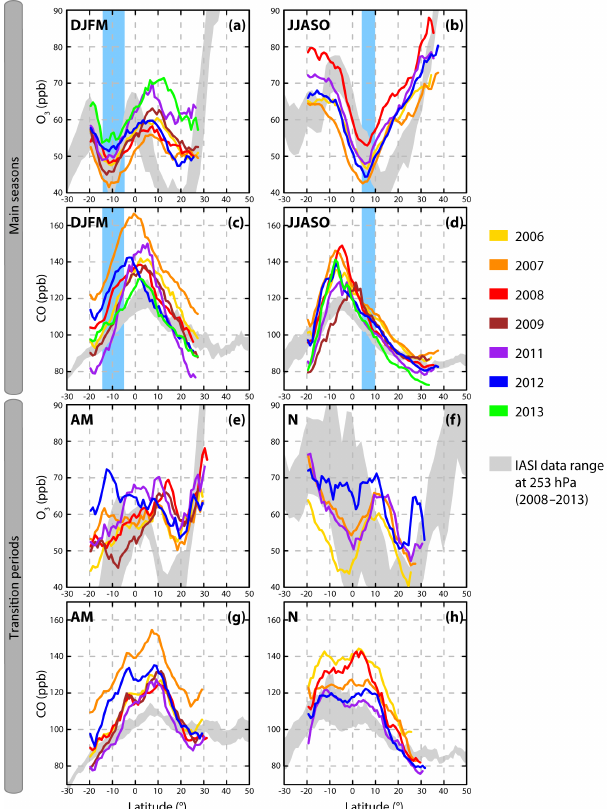
Figure 4. IAGOS meridional and seasonal transects of ozone (a, b, e, f) and carbon monoxide (c, d, g, h) . The vertical blue rectangles represent the deduced ITCZ position. The grey areas represent the IASI data range at 253hPa on the flight trajectories for the 2008 to 2013 period (no data available before